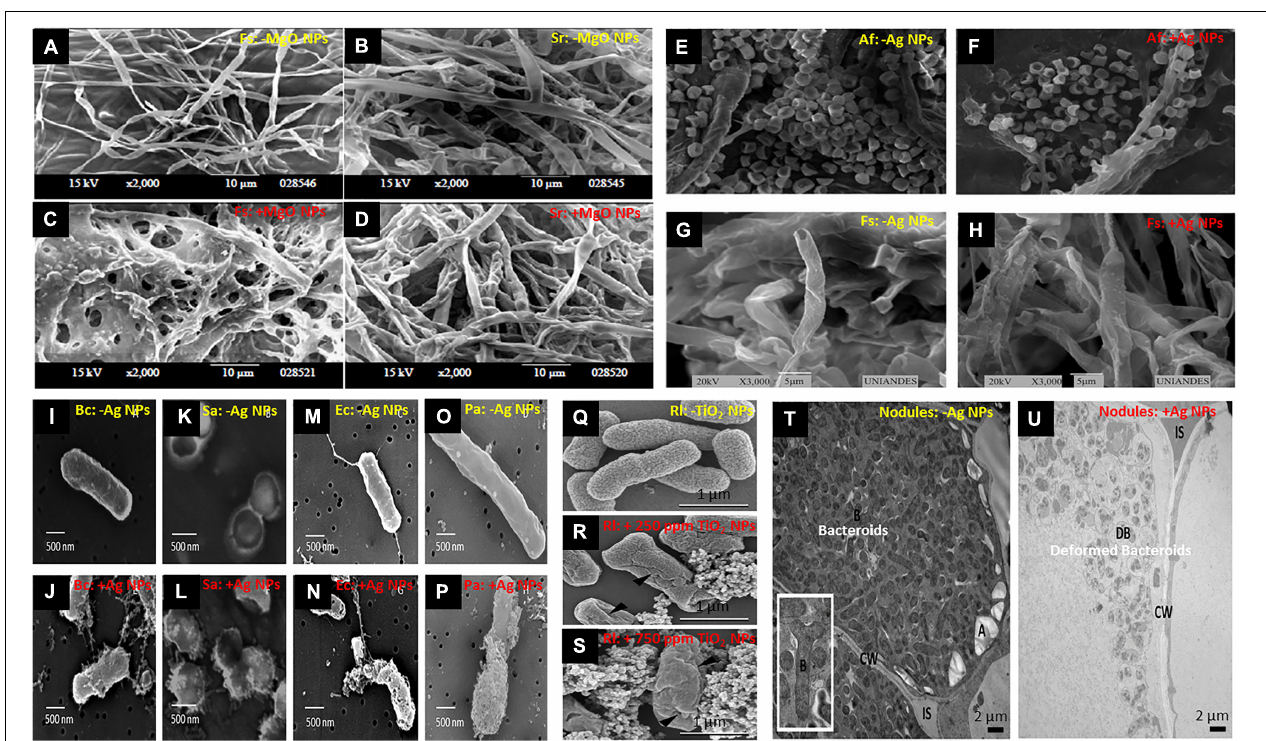
FIGURE 1 | Deformation and damage in fungal hyphae and bacterial cells upon exposure to nanoparticles. (A–D) Scanning electron microscopy (SEM) of hyphae of Fusarium solani and Sclerotium rolfsii , untreated (A,B) or treated (C,D) with 100 ppm of magnesium oxide nanoparticles (MgO NPs), respectively. Some hyphae disintegrated and unusual bulges formed on the surface of fungal hyphae [adapted from El-Argawy et al. (2017)]. (E,F) SEM images of Aspergillus flavus before and after treatment with 50 ppm of silver nanoparticles (Ag NPs), showing dwindling of conidia; (G,H) SEM images of Fusarium solani before and after treatment with 50 ppm of Ag NPs, showing hyphal deformation [adapted from Villamizar-Gallardo et al. (2016)]. (I–P) SEM images of different bacteria, untreated or treated with bactericidal concentrations of Ag NPs: Bacillus cereus (I,J) , Staphylococcus aureus (K,L) , Escherichia coli (M,N), and Pseudomonas aeruginosa (O,P) , indicating membrane damage [adapted from Gopinath et al. (2012)]. (Q–S) Cell surface structure of Rhizobium leguminosarum bv. viciae 3841 shown by SEM micrograph in untreated control, and following exposure to 250 or 750 mg L − 1 of titanium oxide (TiO 2 ) NPs, respectively. ( (cid:78) ) indicates cracks and wrinkles caused by TiO 2 NPs [adapted from Fan et al. (2014)]. (T,U) Transmission electron micrographs (TEM) of the infected zone of untreated and Ag NP-treated nodules, respectively, indicating digestion of peribacteroid membrane and deformed bacteroids (DB) in nodules of treated plants [adapted from Abd-Alla et al.